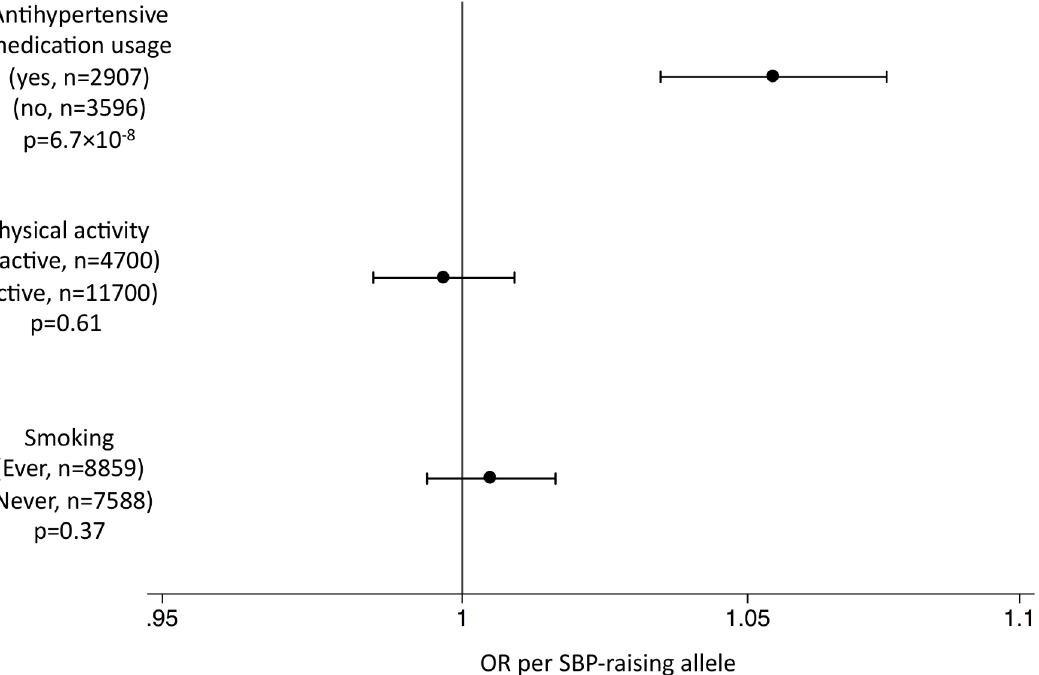
Fig 4. Associations of the systolic blood pressure genetic score with binary outcomes in the EPIC-InterAct study. This figure shows the investigation of pleiotropic associations of the genetic score for SBP with binary outcomes in the EPIC-InterAct study [26]. The OR per SBP-raising allele is